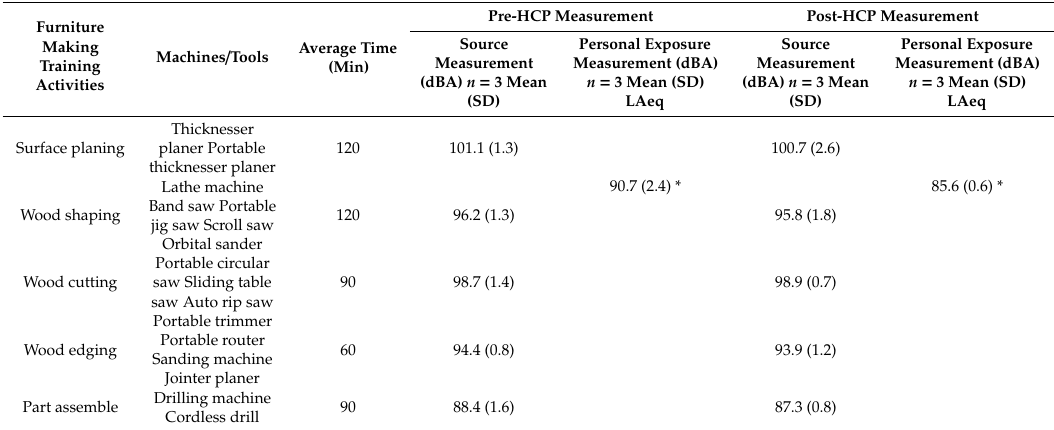
Table 5. Noise exposure monitoring